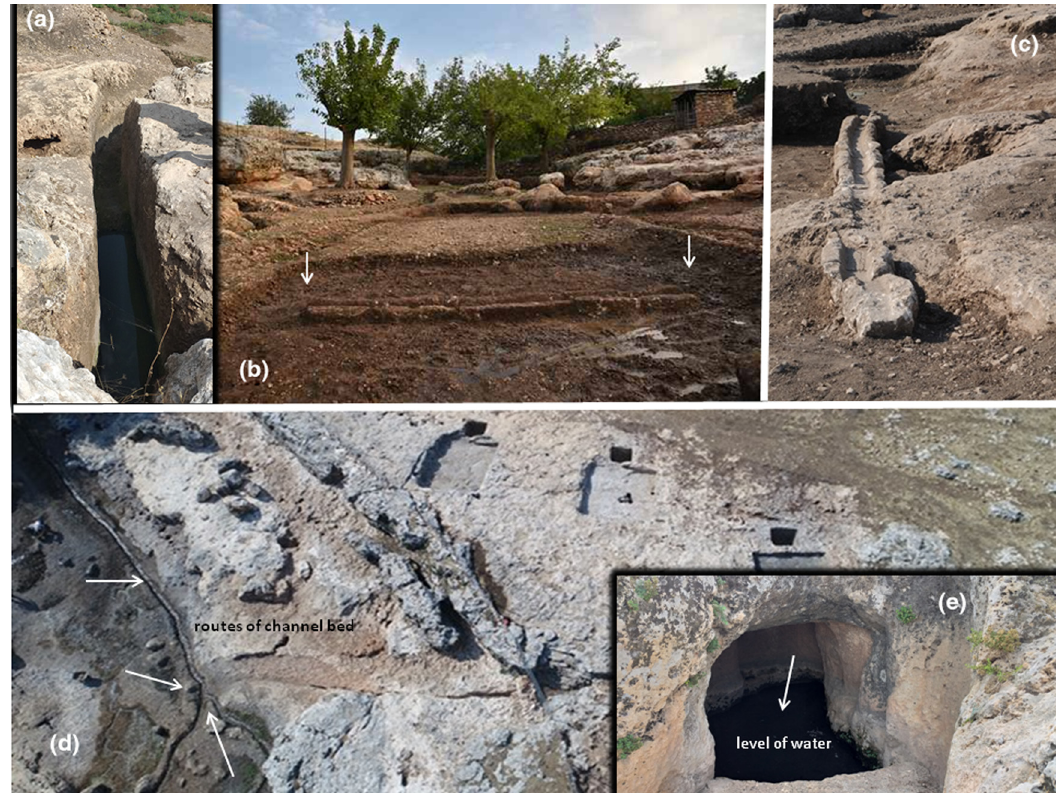
Salvage Excavation Archive )